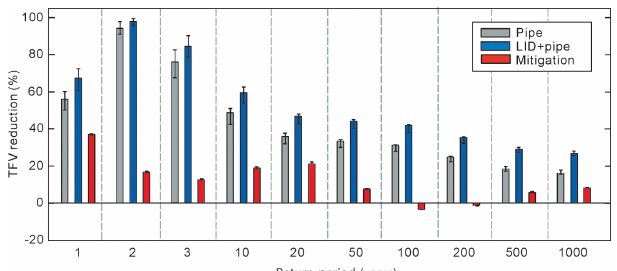
Figure 7. Comparison of benefits of climate mitigation and two adaptation strategies in reducing urban flood volumes with changes in precipitation intensities for various return periods, and with re- lated variations (boundary bars) as a result of uncertainty arising from local soil